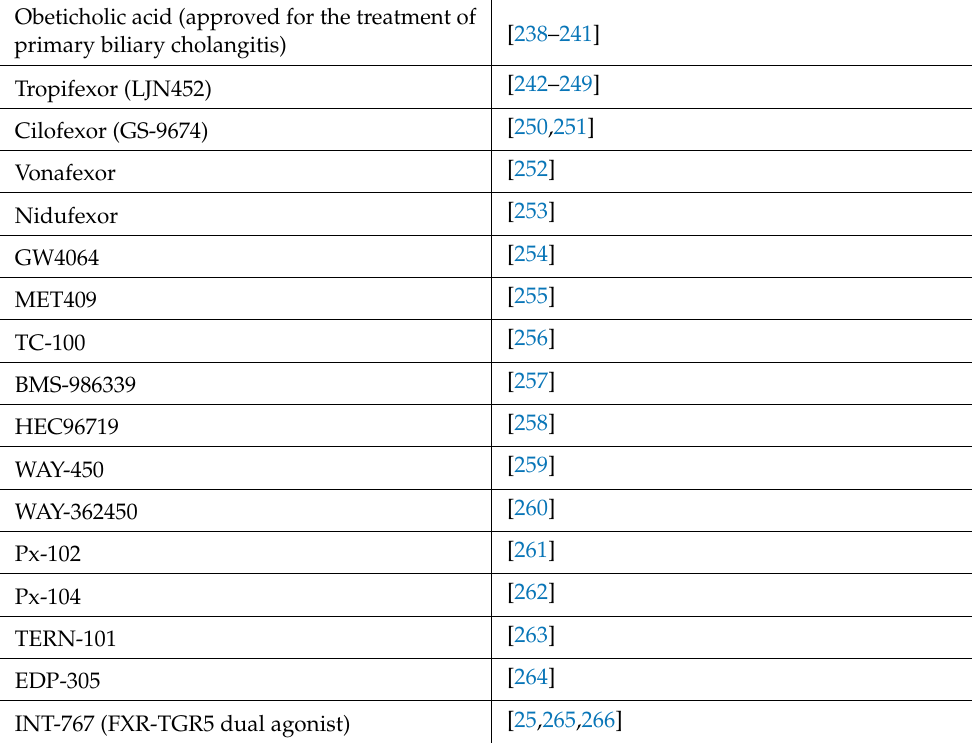
Table 1. FXR agonists/modulators mainly evaluated in clinical or experimental studies. Obeticholic acid (approved for the treatment of primary biliary